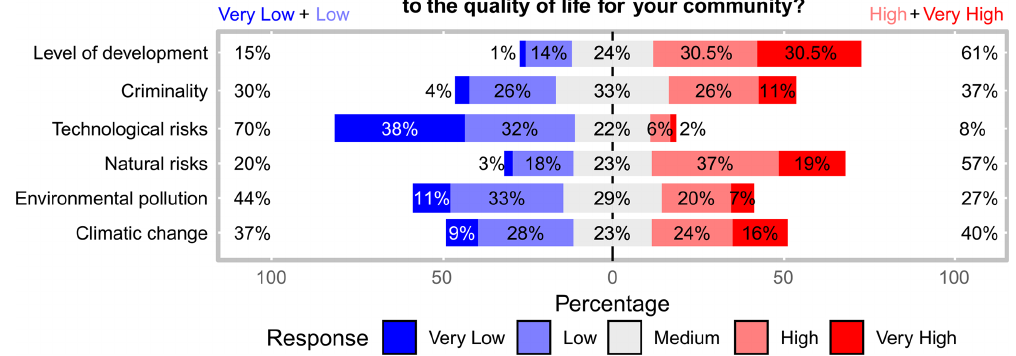
Earthquakes represent the second most threatening